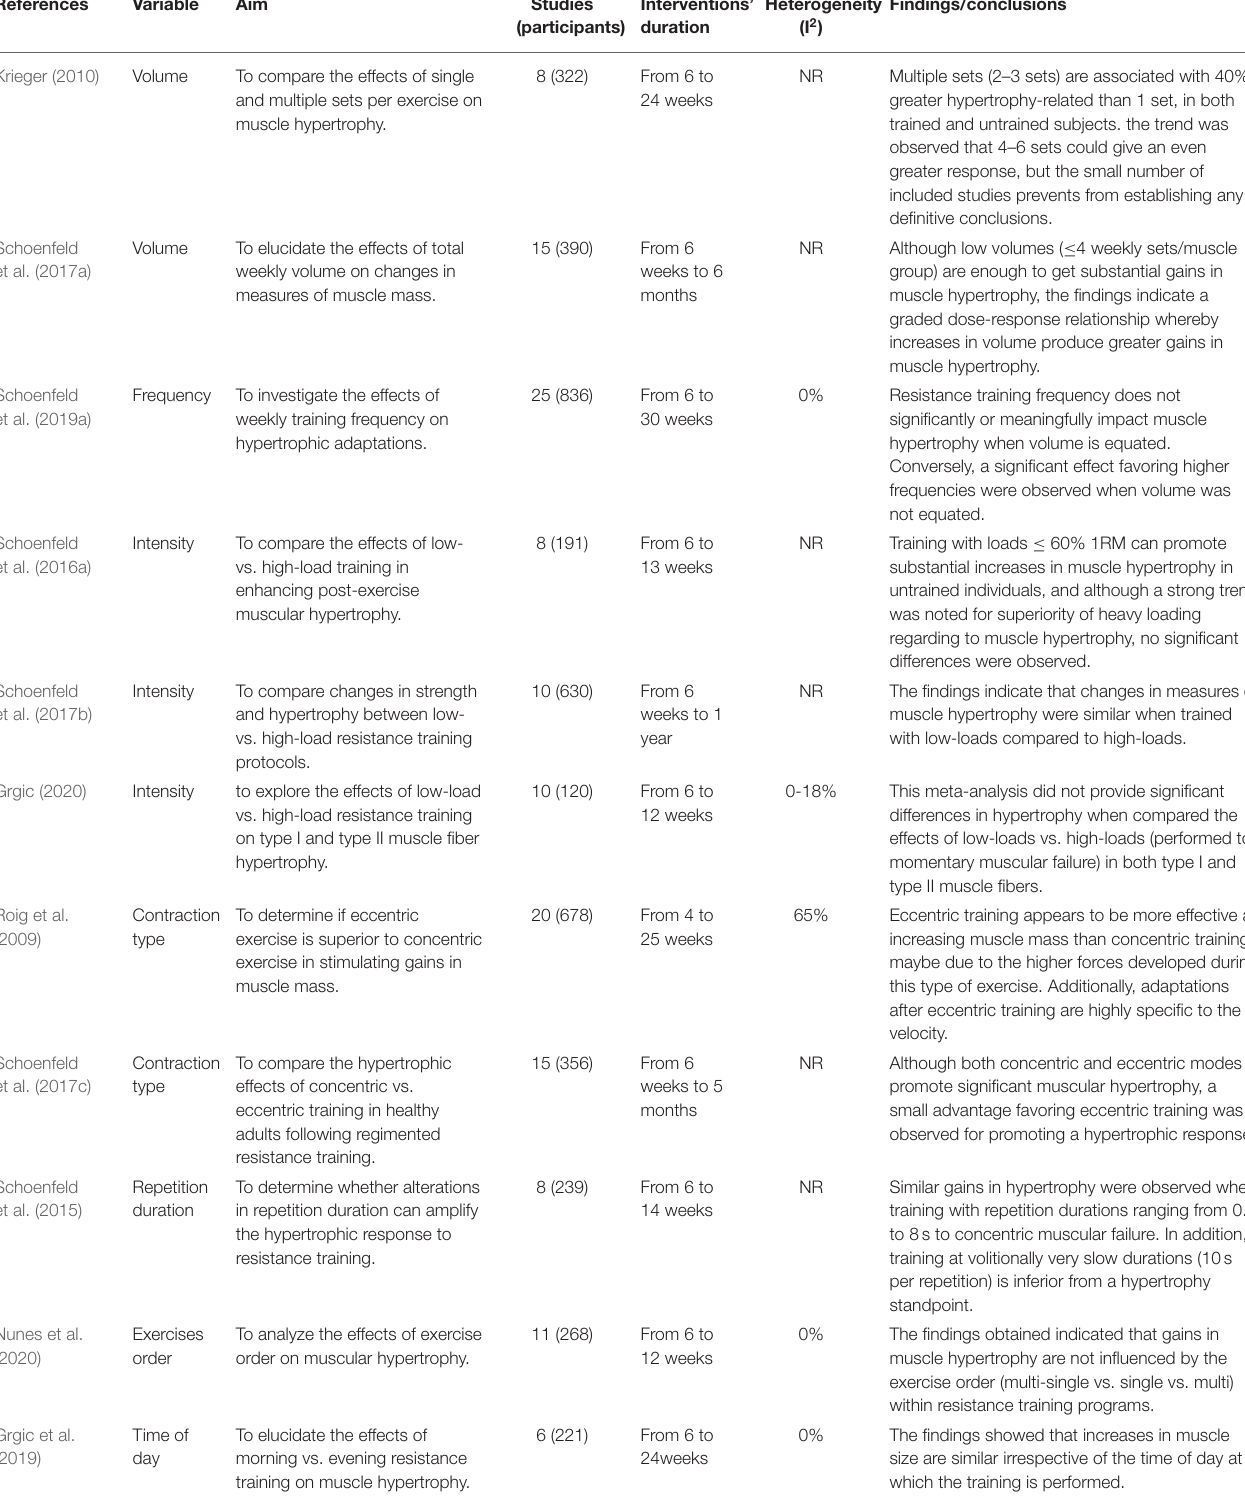
TABLE 1 | Summary of meta-analyses that investigated the effects of modify resistance training variables on